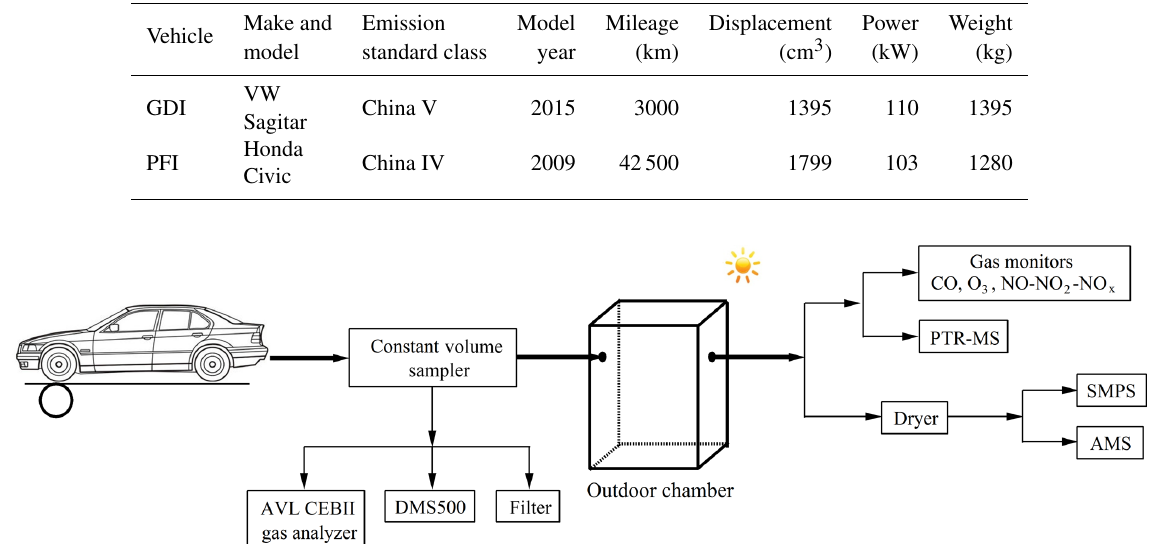
Figure 1. Schematic diagram of the outdoor chamber setup for the